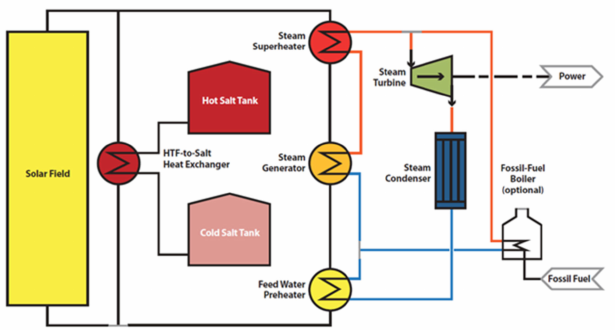
Figure 10. Scheme of a CSP system with a two-tank indirect energy storage system, hybridized with a fossil-fuel backup boiler (optional), adapted from [12].